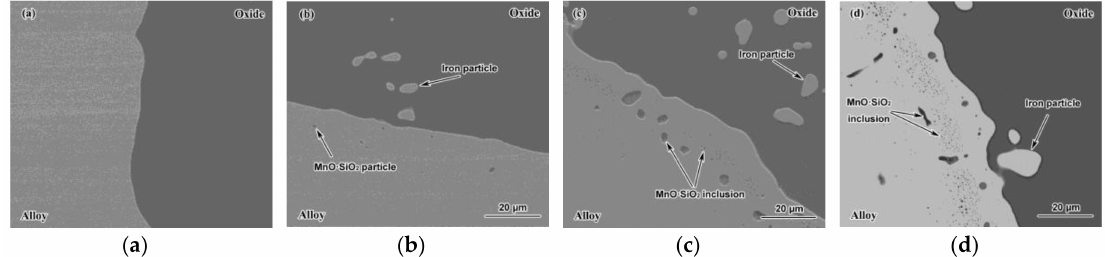
Figure 7. Morphologies of the interfaces between the Fe–Mn–Si alloy and CaO–SiO 2 –Al 2 O 3 –MgO– MnO–FeO oxide in the A-2- x diffusion couples after isothermal heating at 1473 K for 10 h: ( a ) A-2-0; ( b ) A-2-1; ( c ) A-2-2; ( d )